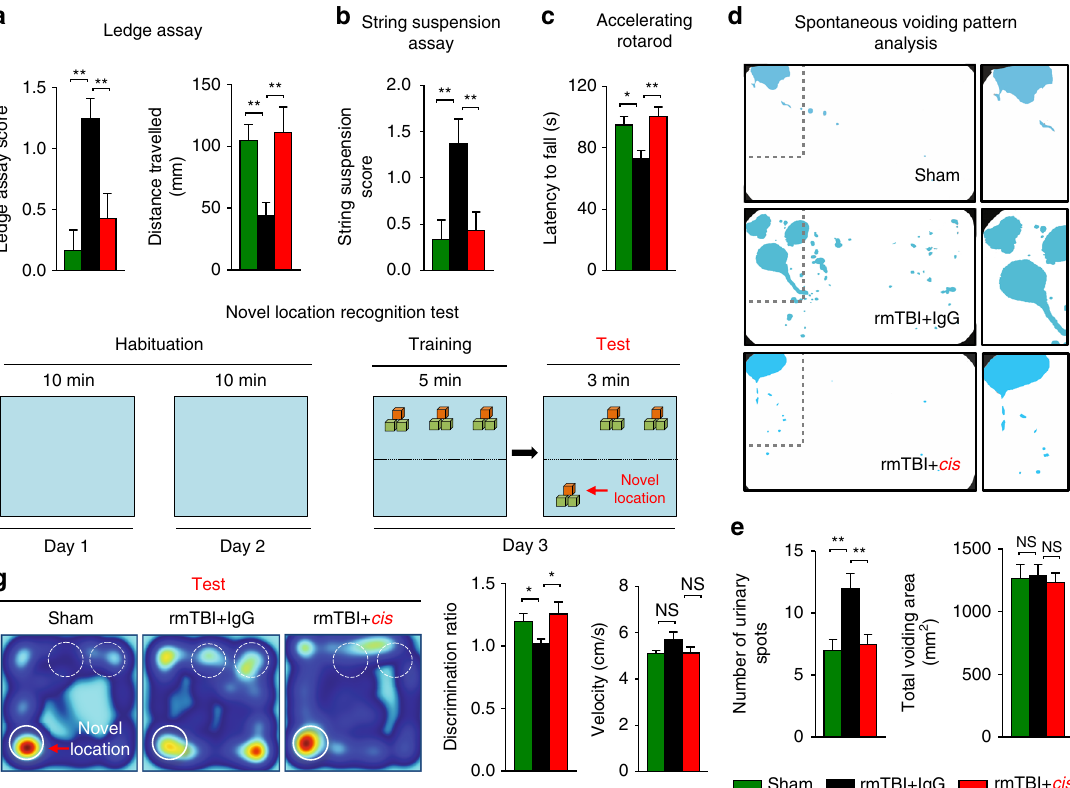
Fig. 8 Eliminating cis P-tau in rmTBI mice with cis mAb prevents the development of clinically relevant functional de fi cits. Cis mAb treatment of rmTBI mice prevents sensorimotor coordination de fi cits, as detected by Ledge assay a , string suspension b and accelerated rotarod c , and urinary incontinence, as assayed by spontaneous urinary pattern analysis d , e and memory de fi cit, as assayed by novel object location recognition test at 6 months after injury f , g . 5 − 6 mice underwent urinary pattern test and 9 − 10 WT mice underwent other behavioral studies per group. The data are presented as means ± SEM. The p -values were calculated using unpaired two-tailed parametric Student ’ s t -test. * p < 0.05, ** p < 0.01, *** p < 0.001, **** p <